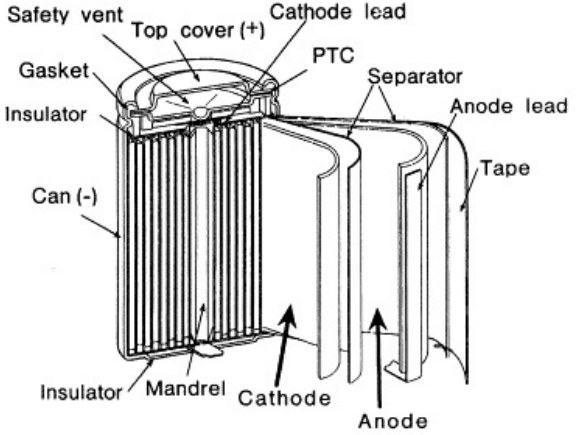
Figure 4. Schematic of a cylindrical Li-ion battery. Adapted with permission from [19], © Elsevier, 2001.